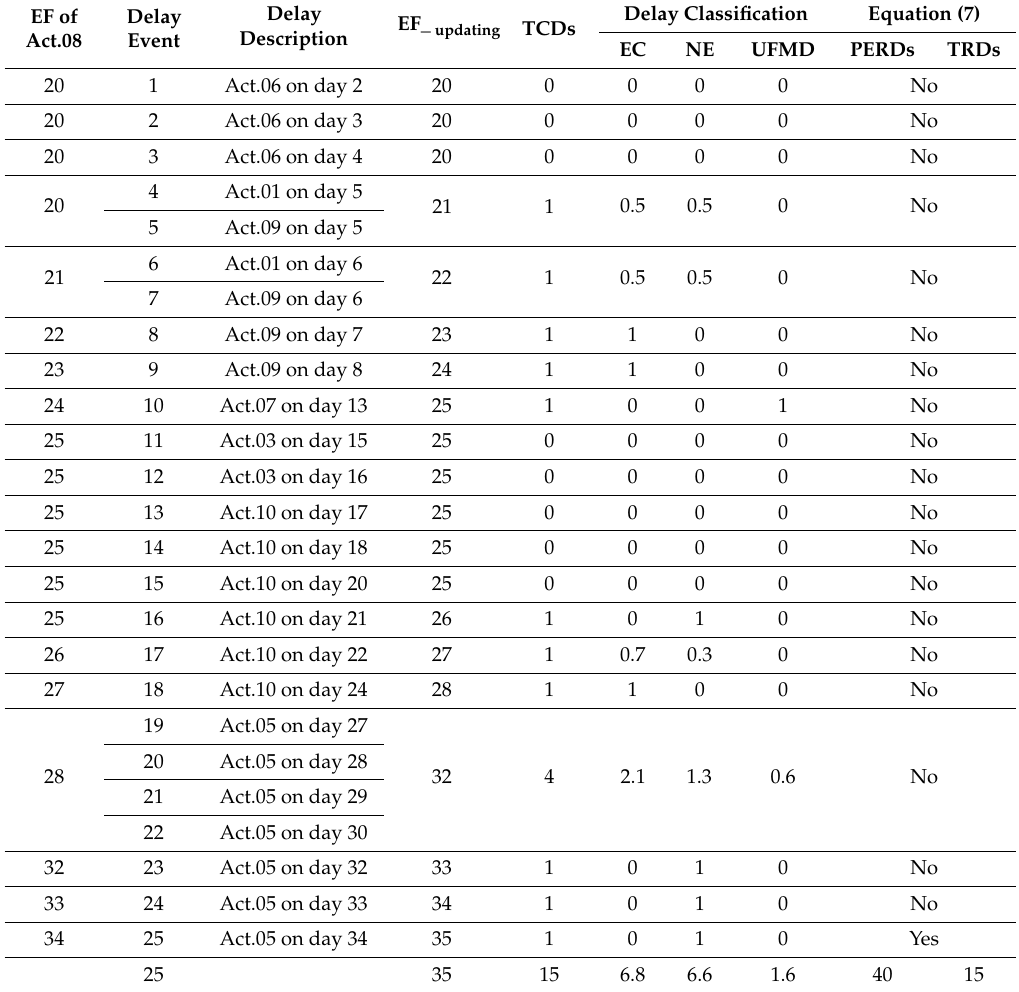
Table 7. The analysis results for period (35–39).